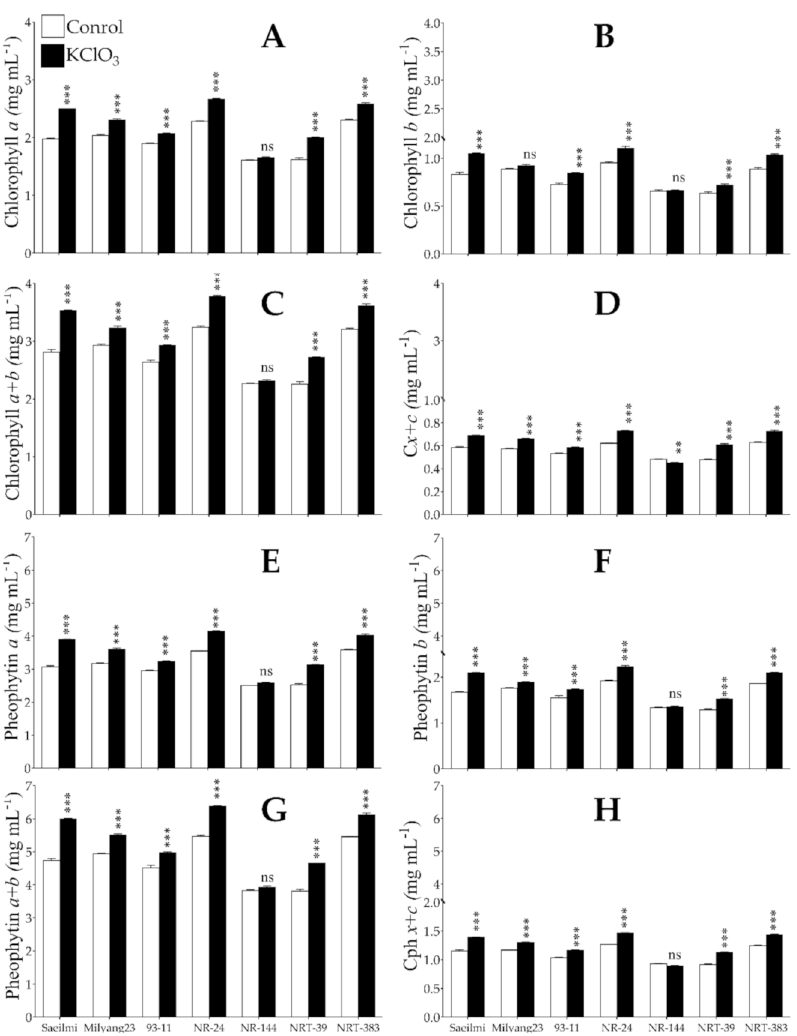
Figure 4. Pattern of chloroplast pigment content under potassium chlorate treatment. ( A – D ) Chloro- phyll a , b , a + b , and carotenoids relative to chlorophyll (C x + c ), respectively, ( E – H ) Pheophytin a , b , a + b , and carotenoid relative to pheophytin (C ph x + c ), respectively. Bars are mean values of triplicates ± SE. *** p < 0.001, ** p < 0.01, ns